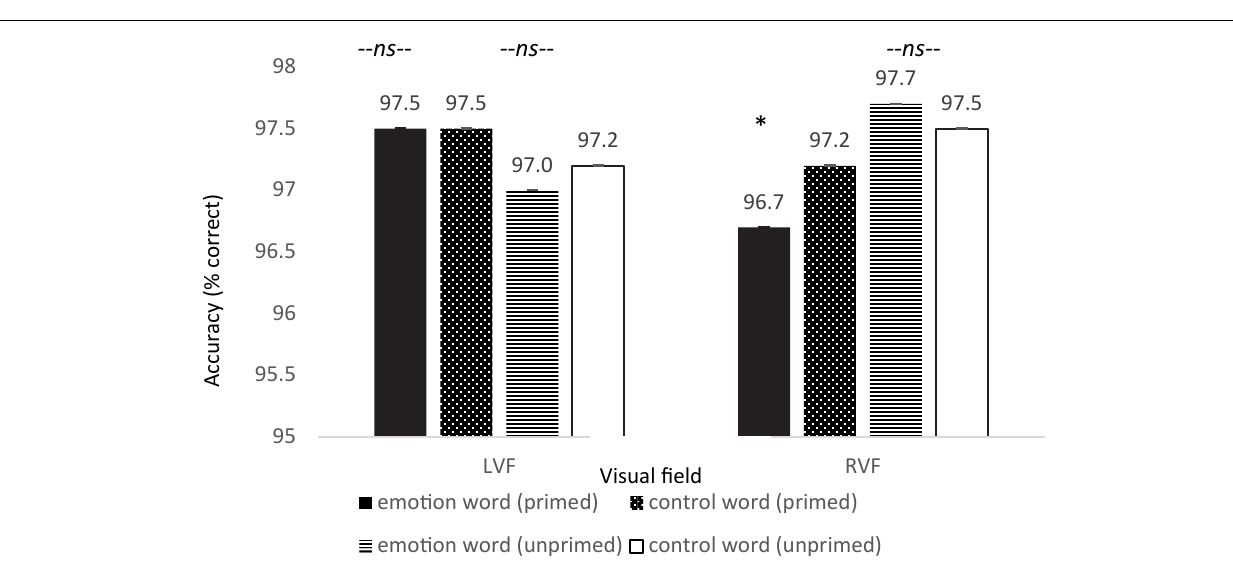
FIGURE 5 | Reaction time differences between pair types by visual field for Experiment 2. There was a significant effect for the primed trials but only in the RVF (left-hemisphere) between emotion words and control words, in line with the hypothesis that participants would be slower to respond due to elaborative linguistic processing to trials preceded by an emotion word that is able to be integrated with the